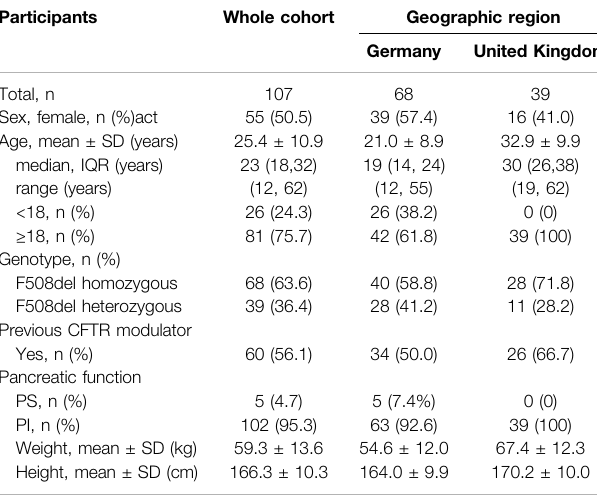
TABLE 1 | Baseline demographics and clinical characteristics of the pwCF included in the study. None of the included pwCF carried a gating mutation, and none was previously treated with ivacaftor